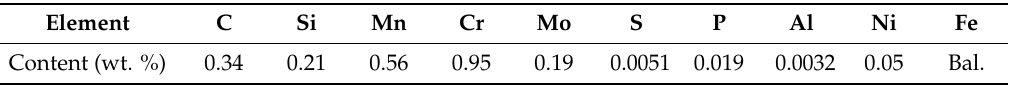
Table 1. Chemical composite of 35CrMo steel in mass